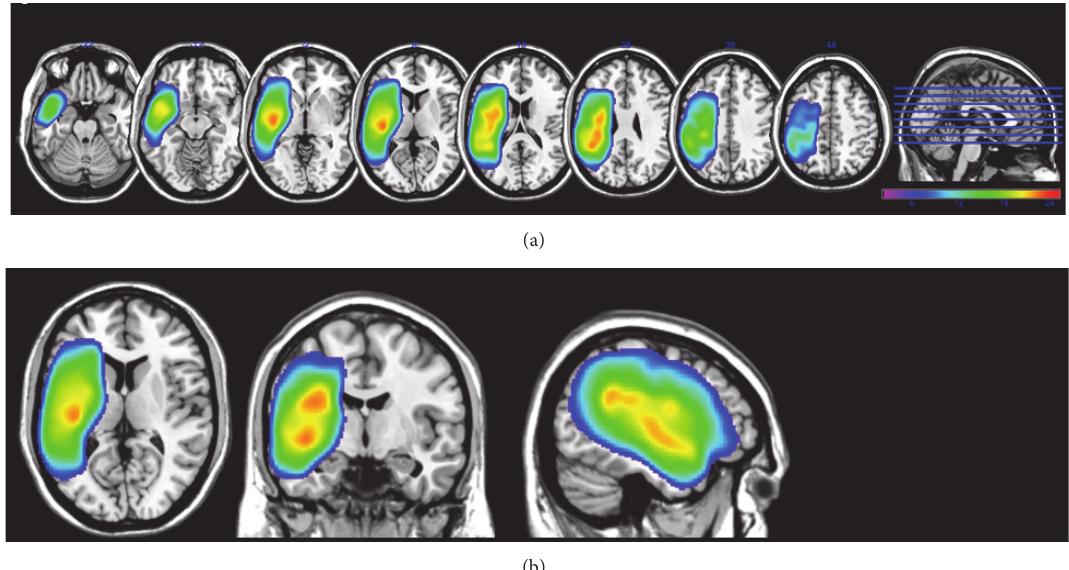
Figure 1: Lesion overlap map for 35 participants with aphasia, by axial slices (a) and with a three-dimensional view (b), using the neurological convention (left hemisphere is on the left). The color bar indicates the degree of overlap from minimal overlap (violet; 𝑁 = 2 participants overlapping) to maximum overlap (red; 𝑁 = 25 participants overlapping). The overlap map was spatially smoothed